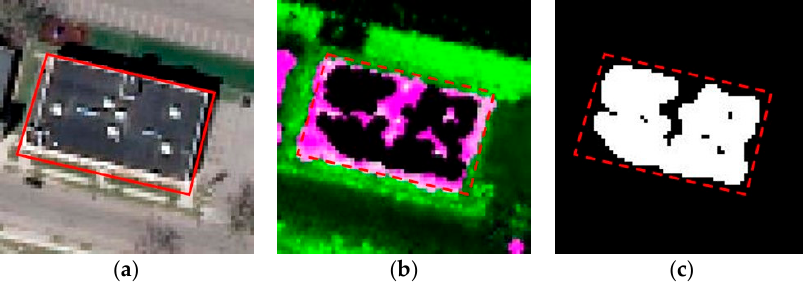
Figure 7. The spatial correspondences for the no-data area between multi-temporal LiDAR data and the high-resolution image: ( a ) high-resolution image; ( b ) LiDAR data; and, ( c ) mask for no-data area. a ) high-resolution image; ( b ) LiDAR data; and, ( c ) mask for no-data area. The red rectangle indicates the schematic object from the high-resolution image. the high-resolution image: ( The red rectangle indicates the schematic object from the high-resolution